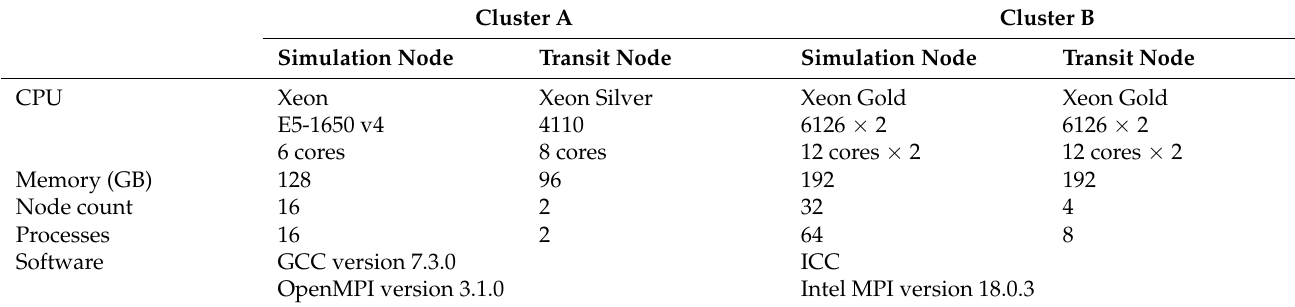
Table 2. Test environments. Each cluster system has Infiniband EDR as its